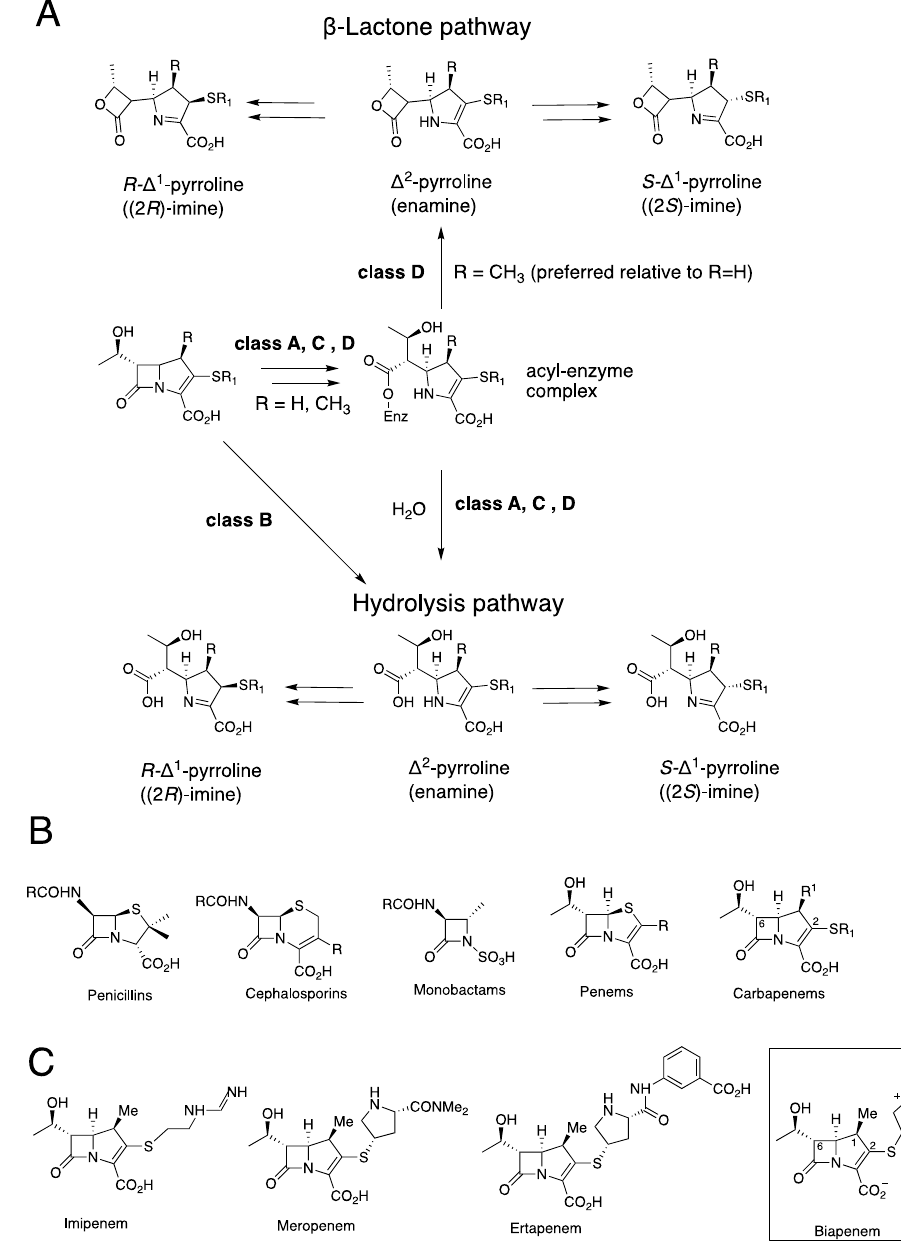
Figure 1. Carbapenem hydrolysis by β -lactamases. ( A ) It is proposed that SBLs and MBLs hydrolyse carbapenems to produce an enamine ( ∆ 2 -pyrroline), which during efficient catalysis in solution isomerises to give (2 R )- and (2 S )- ∆ 1 -imine products. Both enamine and (2 S )- and (2 R )-imine carbapenem-derived ligands have been observed by crystallography at MBL/SBL/transpeptidase active sites. Lactones can also be formed, at least, in the case of class D SBLs. ( B ) Classes of clinically used β -lactam antibiotics (for carbapenems R 1 = H or Me). ( C ) Examples of clinically used carbapen- ems; note the unusual positively charged bicyclic bicyclotriazolium C2 side chain of